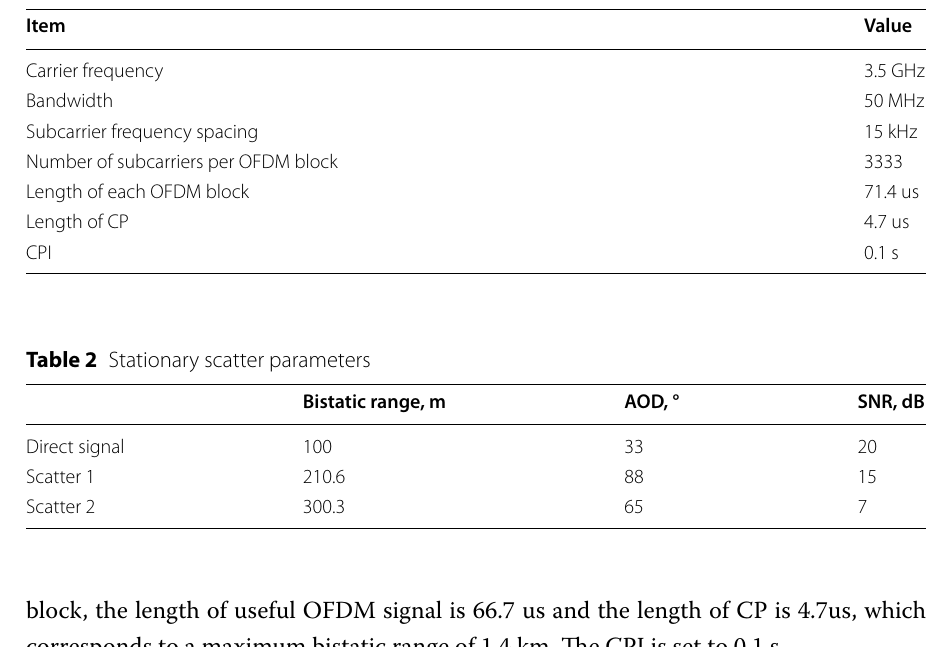
Table 1 Signal parameters Item